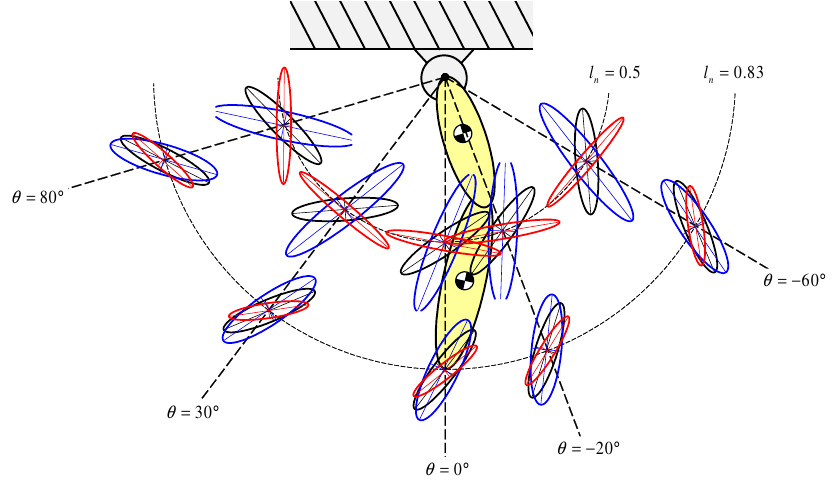
Figure 9. CIEs depending on a segment ratio: r > 1 (red), r < 1 (blue), and r = 1